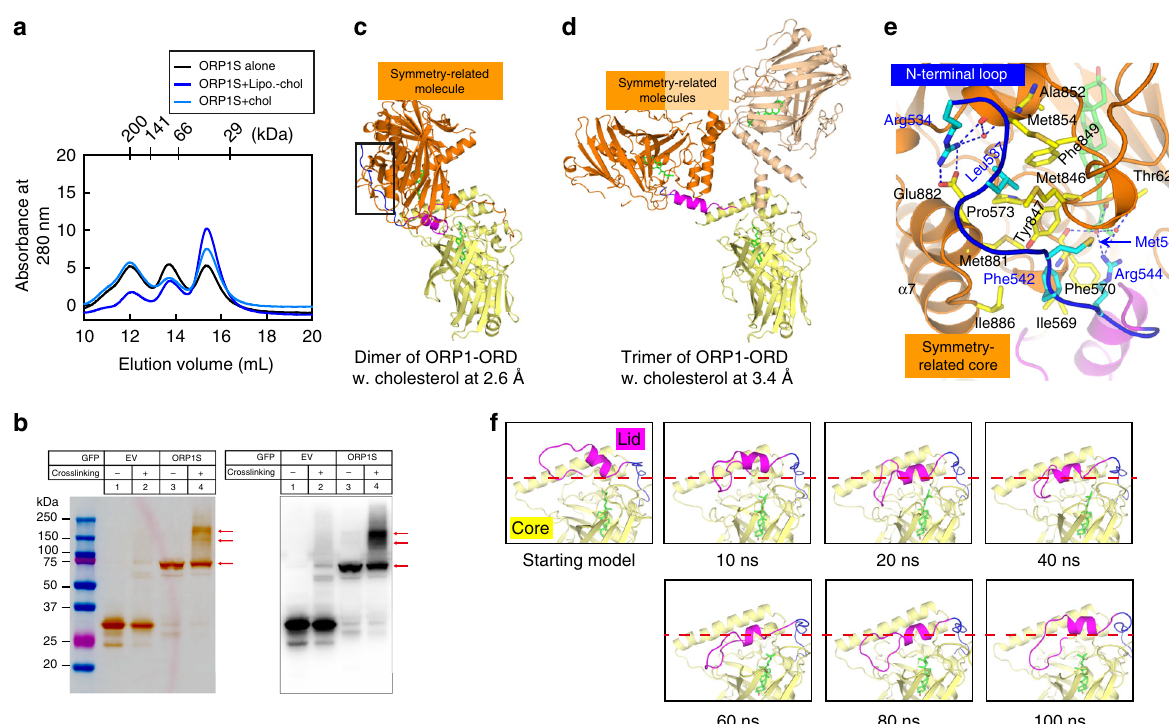
Fig. 5 ORP1-ORD has three oligomeric states in vitro and in vivo. a Gel fi ltration analyses of ORP1S in isolation and in complex with cholesterol. b Immunoblot analysis of the oligomeric states of ORP1S. c , d The domain-swapping dimer ( c ) and trimer ( d ) of cholesterol-bound ORP1-ORD. e Close-up view of the domain-swapping interactions between the N-terminal loop (blue) and the symmetry-related core (orange) in the dimer shown in c . f Snapshots at indicated time points during the MD simulations for monomeric ORP1-ORD complexed with